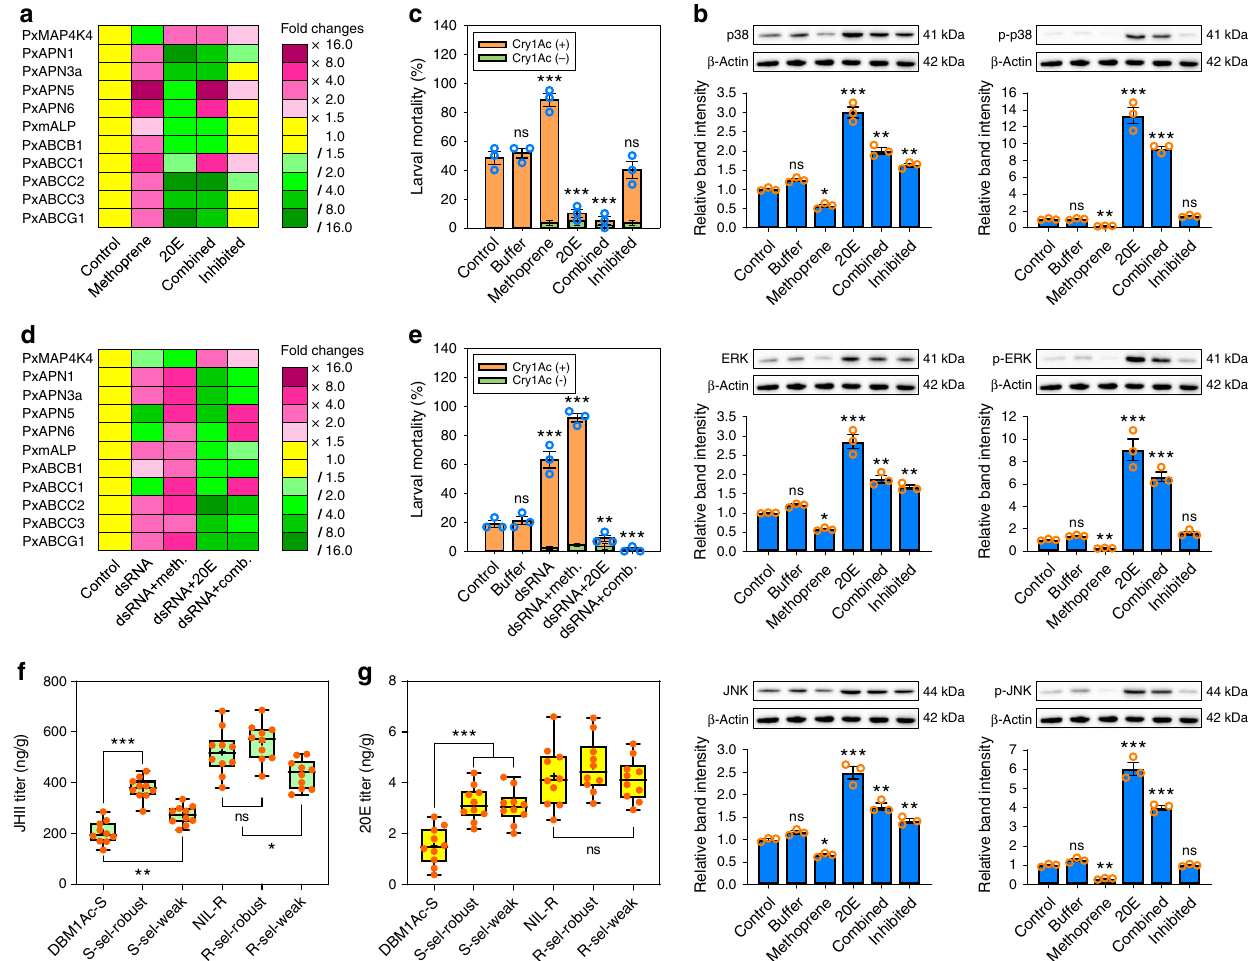
Fig. 6 Effect of hormone titers in susceptible and resistant P. xylostella . a Effect of methoprene and 20E treatments on gene expression levels in the injected DBM1Ac-S larval midguts. Gene expression level at 0 h was assigned a value of 1 for comparison, which are displayed as expression fold changes and color-coded according to the gradient. b Effect of methoprene and 20E treatments on protein expression and phosphorylation levels of three key MAPK downstream kinases p38, JNK, and ERK in the injected DBM1Ac-S larval midguts. Both the detection of protein and phosphorylation levels by Western blots (upper row) and quantitative estimation of band intensity by densitometry (graph) are presented. c Susceptibility to Cry1Ac protoxin (LC 50 , 1 mg/L) in the exogenous hormone-treated DBM1Ac-S larvae. d , e Effect of exogenous hormone treatment on midgut gene expression levels ( d ) and susceptibility to Cry1Ac protoxin (LC 20 , 0.3 mg/L) ( e ) in the PxMAP4K4 -silenced DBM1Ac-S larvae. f , g Box plots show the detection of Cry1Ac toxin- induced JH II ( f ) and 20E ( g ) titers in unselected or Cry1Ac-selected robust and weak DBM1Ac-S and NIL-R larvae. Each orange dot represents mean hormone titer in two 1-day-old fourth-instar larvae and black plus sign indicates mean hormone titer of all the detected individuals in each strain. Median and quartile values are provided by the central line and box boundaries, whiskers show min to max values. Data are presented as mean values ( a , d ) and mean values ± SEM ( b , c , e – g ), n = 3 ( a – e ) and n = 10 ( f , g ) biologically independent samples, * p < 0.05, ** p < 0.01, *** p < 0.001, ns, not signi fi cant, one- way ANOVA with Holm – Sidak ’ s test was used for comparison. Source data are provided as a Source Data fi